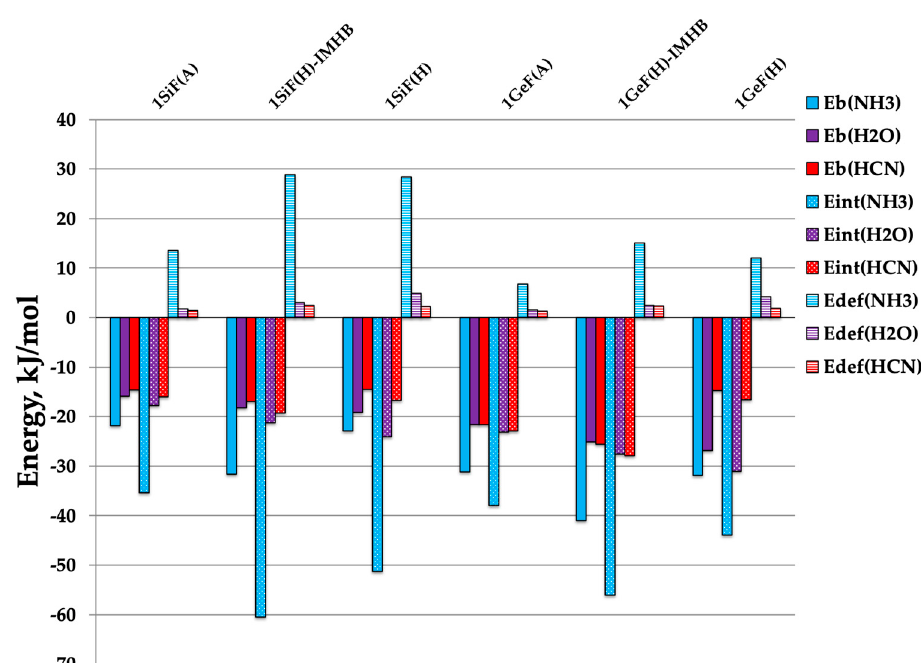
Figure 2. Histogram for the different energies: E b (solid), E int (dotted) and E def (stripped) for each Lewis base considered: NH 3 ( blue ), H 2 O ( purple ) and HCN ( red ).